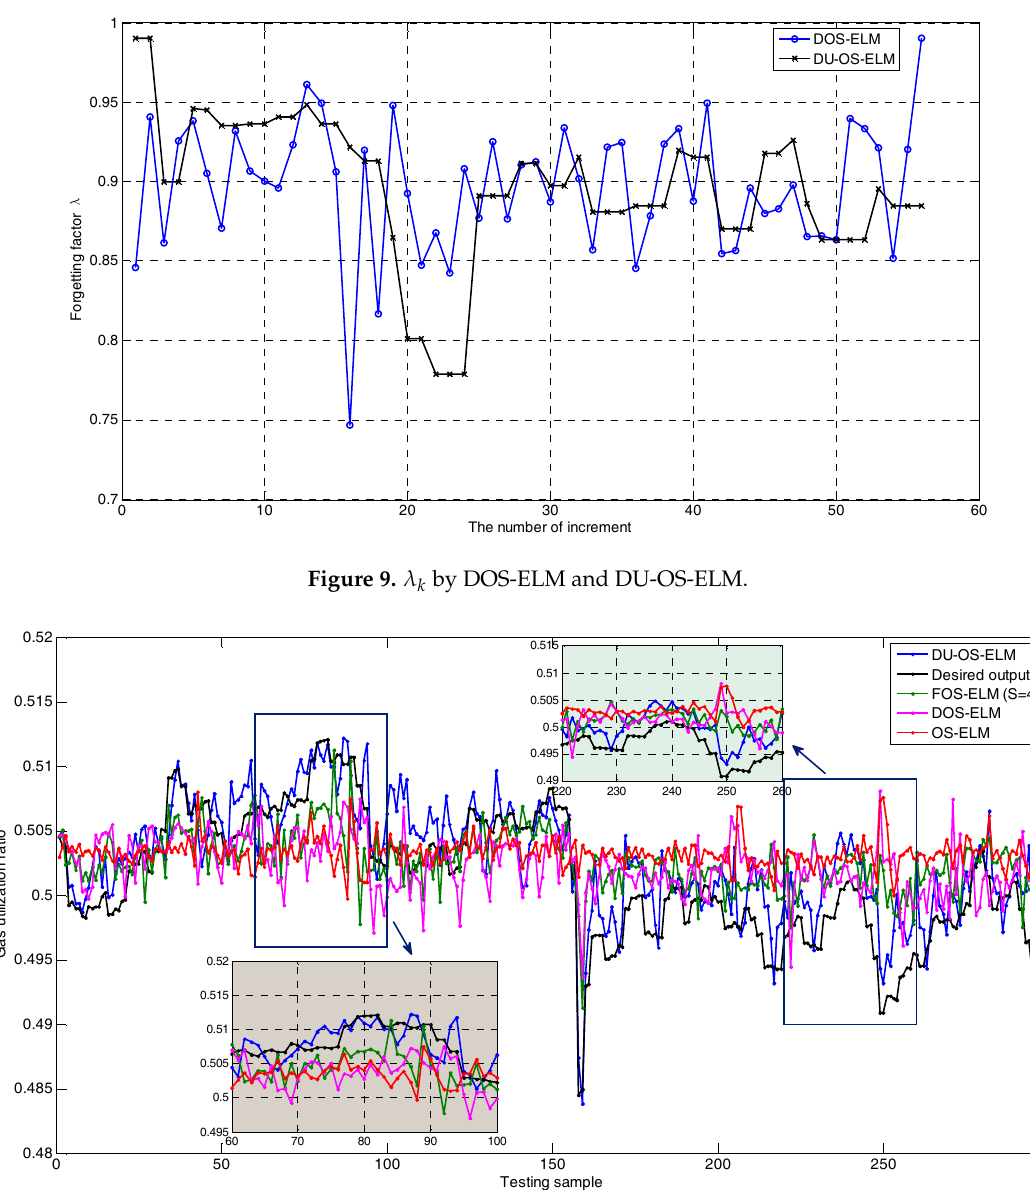
Figure 10. Simulation results of different approaches.